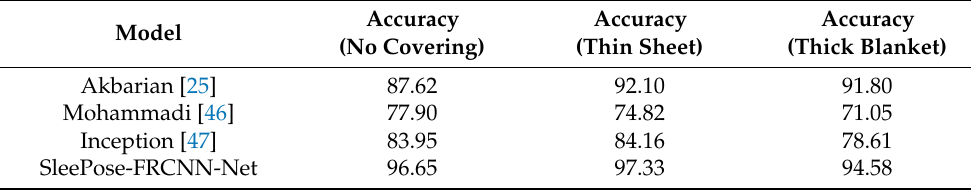
Table 11. Results of head pose classification on the iSP pilot dataset.